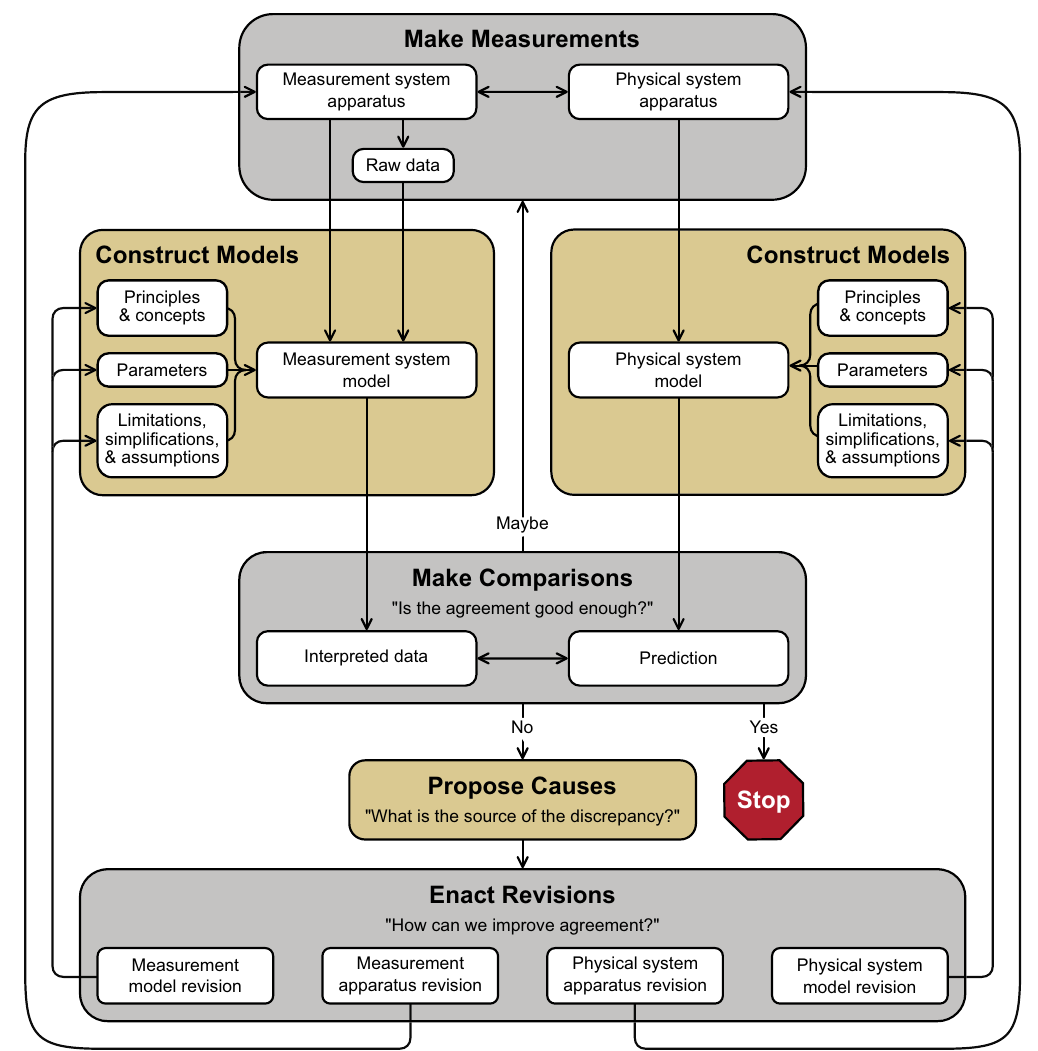
FIG. 1. Diagram of the Experimental Modeling Framework, which describes the process of modeling in experimental physics. This figure was first published in Ref. [42] and is a modified version of the original framework developed in Ref. [4]. The shaded boxes show the main tasks of modeling with the connecting arrows indicating the iterative nature of the modeling